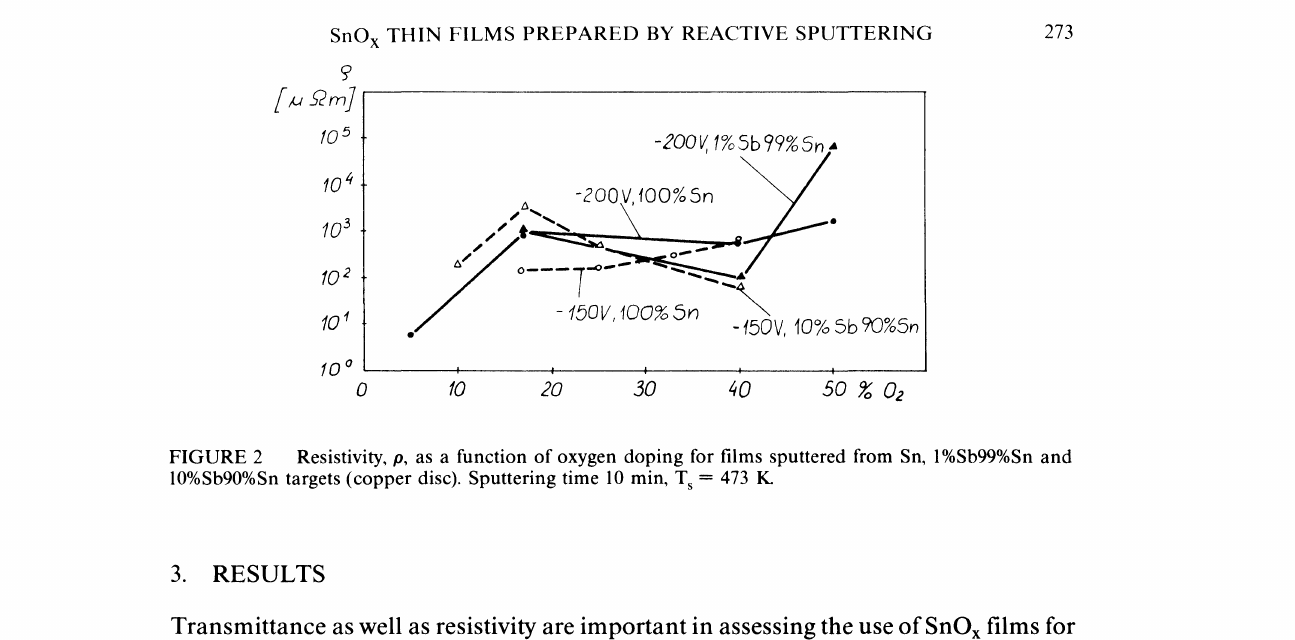
Resistivity, O, as a function of oxygen doping for films sputtered from Sn, l%Sb99%Sn and 10%Sb90%Sn targets (copper disc). Sputtering time 10 min, T 473 K.